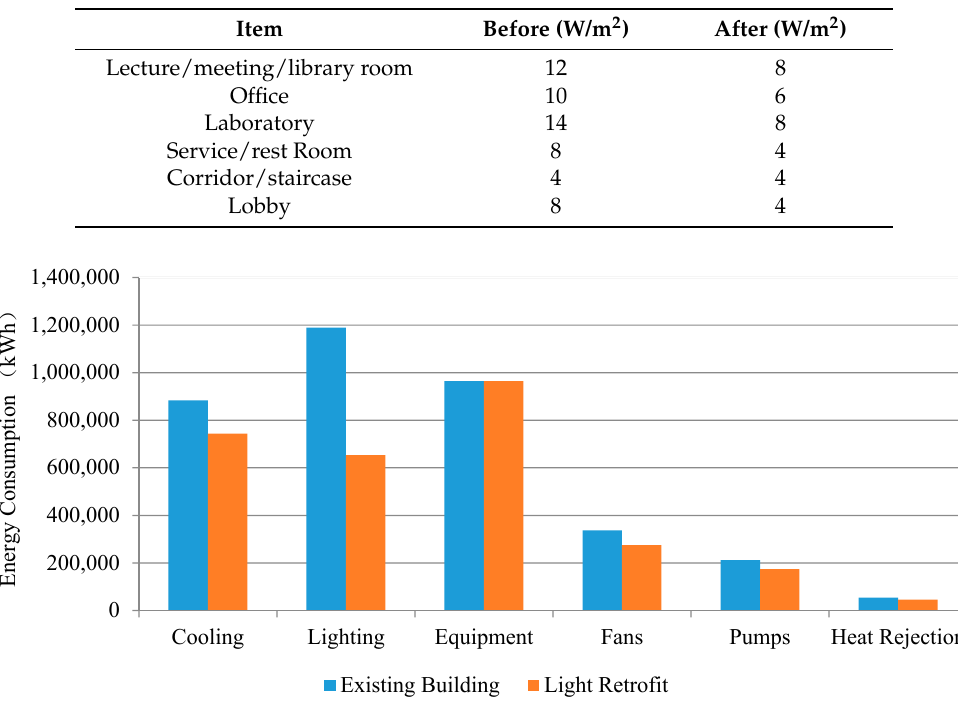
Table 7. Lighting Power Density for the existing condition and after the lighting retrofit.